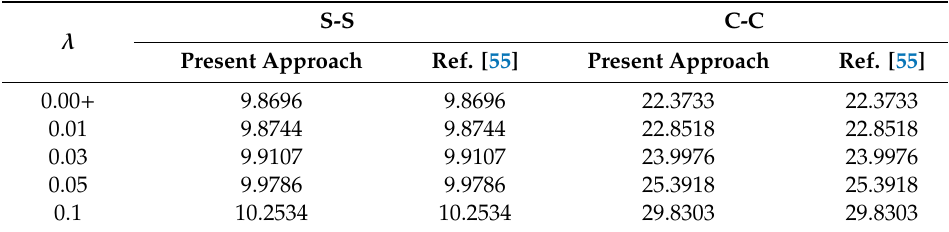
Table 2. Linear dimensionless natural frequencies of homogeneous simply-supported (S-S) and